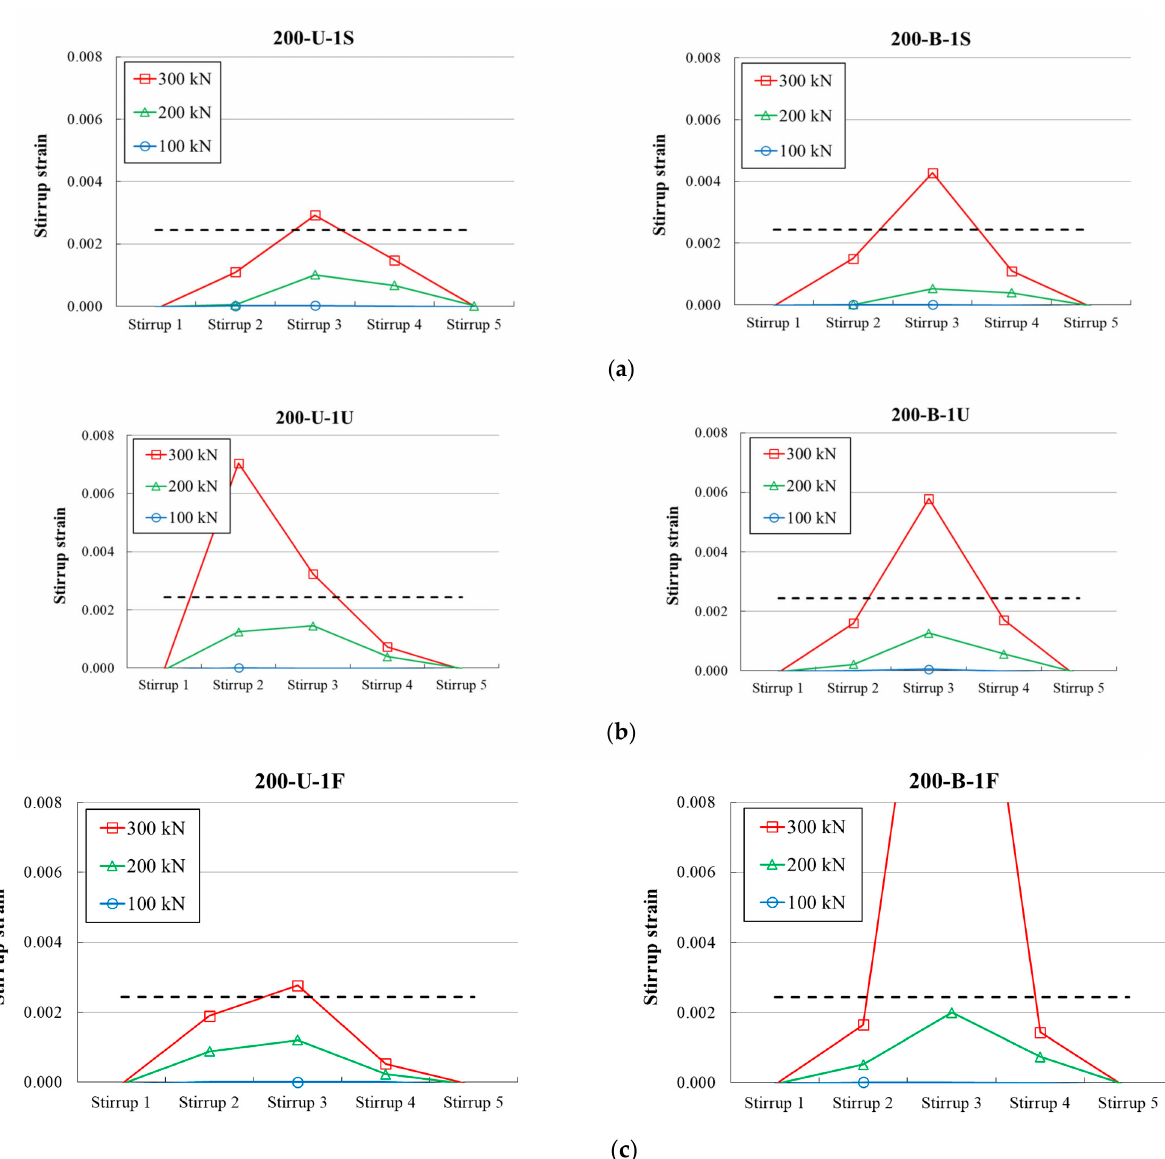
Figure 11. Measured stirrup strains of second series of specimens: ( a ) 200mm spacing; ( b ) 100mm spacing; ( c ) 100mm spacing—repaired.